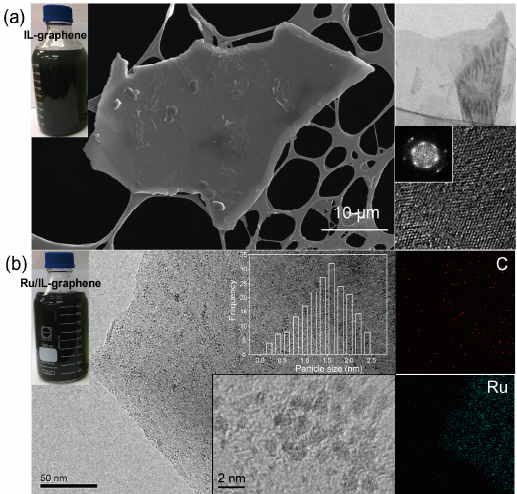
Figure 2. ( a ) SEM, TEM, and HR-TEM images of IL–graphene (the left inset is a photographic image of IL–graphene dispersion, and the right inset is selected area electron diffraction (SEAD) pattern of IL–graphene). ( b ) TEM and elemental mapping (C and Ru) images (left inset is photograph image of RuO 2 /IL–graphene dispersion and the right inset is HR-TEM image of RuO 2 /IL–graphene).